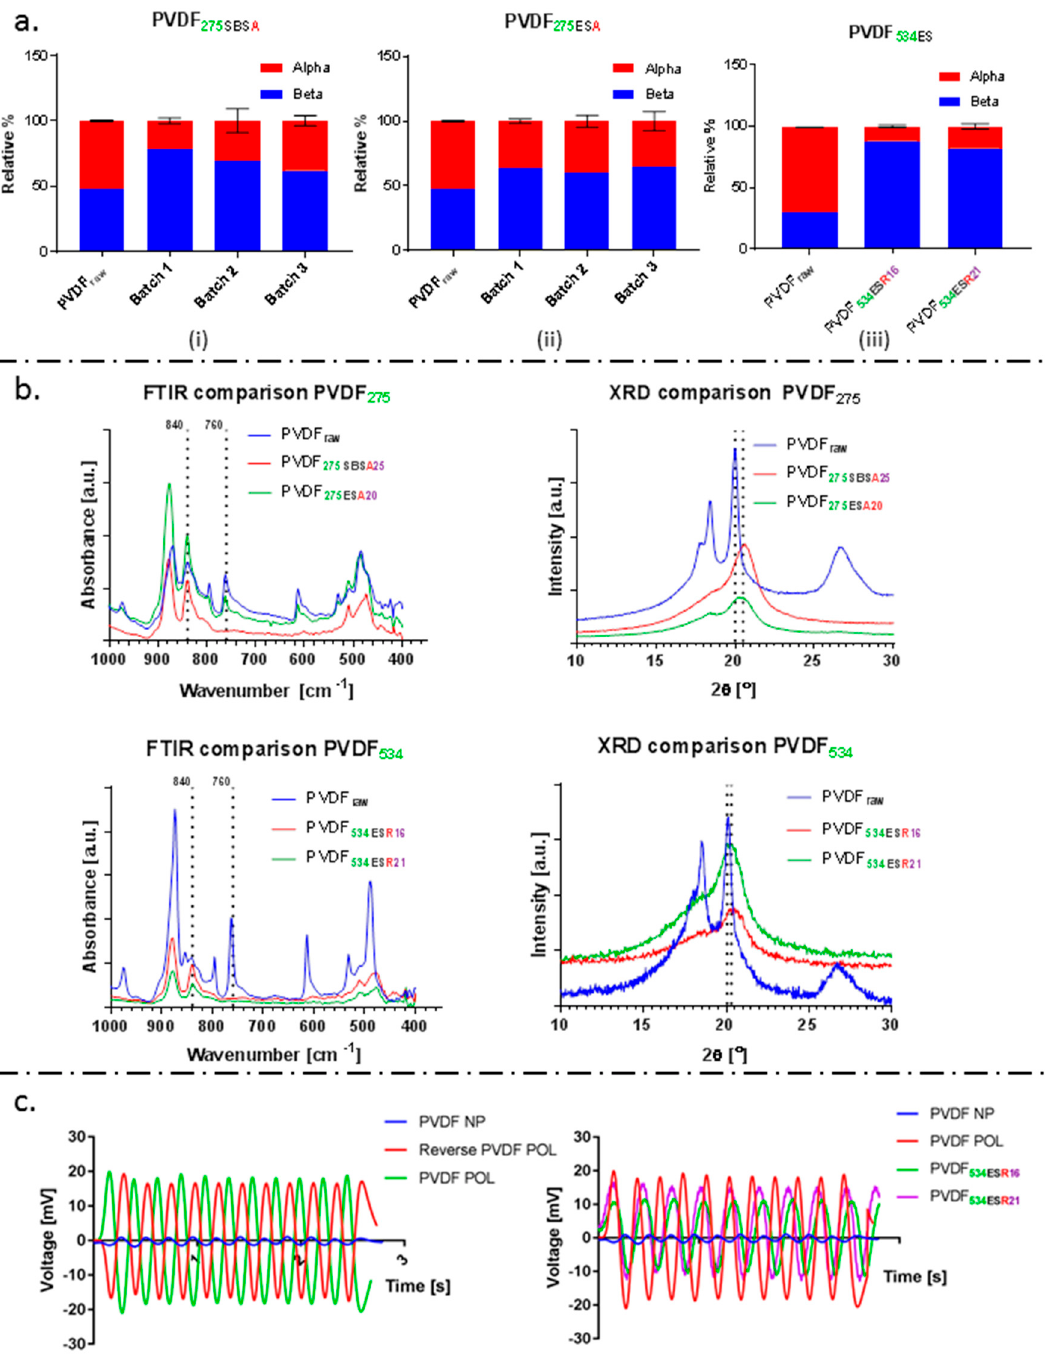
Figure 4. ( a ) Batch-to-batch variation of the relative% of α - and β -phase in (i) SBS fibre mats, (ii) ES fibre mats, and (iii) amount of α - and β -phase present in micron and sub-micron ES fibre mats in comparison to raw PVDF. ( b ) Representative FTIR and X-RD graphs of the different fibre mats fabricated. Vertical dotted lines in FTIR graphs represent the characteristic peaks for α - (760 cm -1 ) and β - (840 cm -1 ) phase. A peak shift from ~2 θ = 20° to ~2 θ = 20.3° and the suppression of peaks at ~2 θ = 18.5° and ~2 θ = 26.7° determined for the fibre mats is evidence of conversion from α -phase to the electroactive β -phase when the raw polymer is processed into fibres. ( c ) Piezoelectric voltage response obtained for control PVDF films and comparison to the response obtained for the fibre mats fabricated using PVDF 534 . A peak-to-peak voltage of 2.25 mV, 33.64 mV, 21.94 mV and 27.24 mV was observed for PVDF NP film, PVDF POL film, PVDF 534ESR16 and PVDF 534ESR21 fibre mats, all respectively.